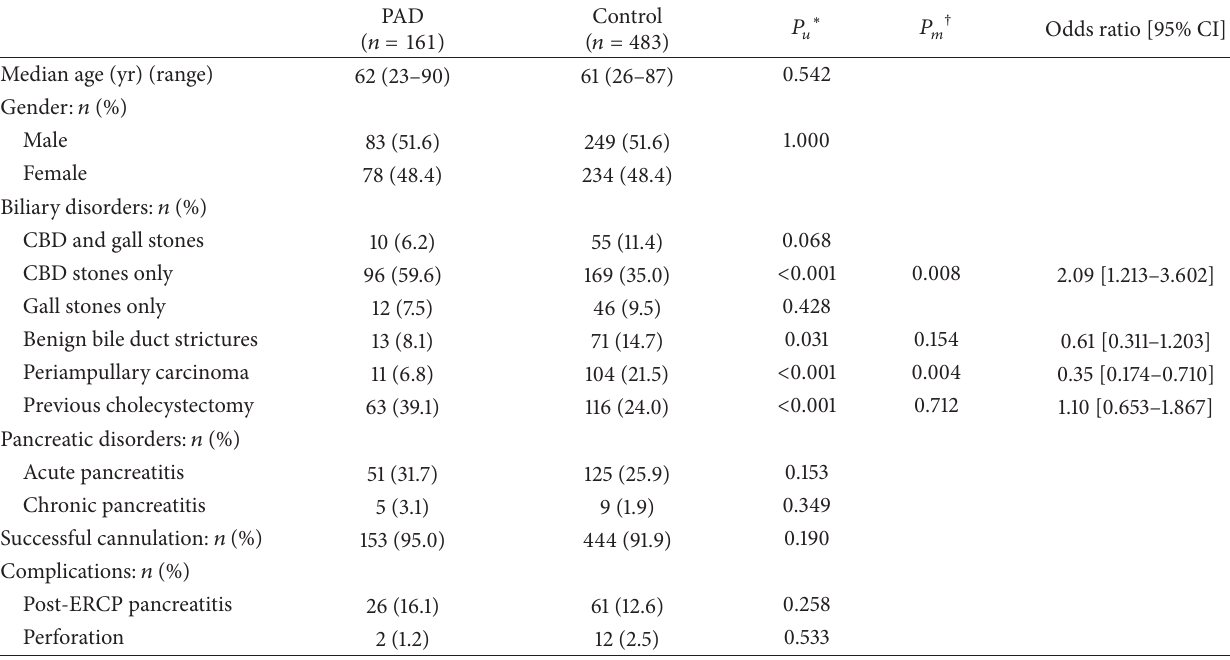
Table 1: Comparison of cholangiopancreatic disorders and technical success of ERCP according to the presence of PAD.